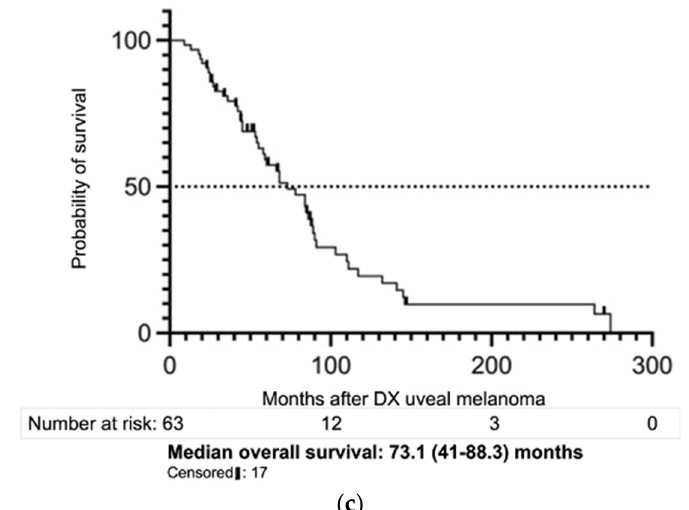
Figure 3. Overview of median overall survival (OS). Survival assessment after percutaneous hepatic perfusion (PHP): median overall survival (OS) in months ( a ) after the first PHP ( n = 61), ( b ) after the date of first diagnosis (DX) of liver involvement ( n = 61), and ( c ) after the date of DX of the uveal melanoma ( n = 60).